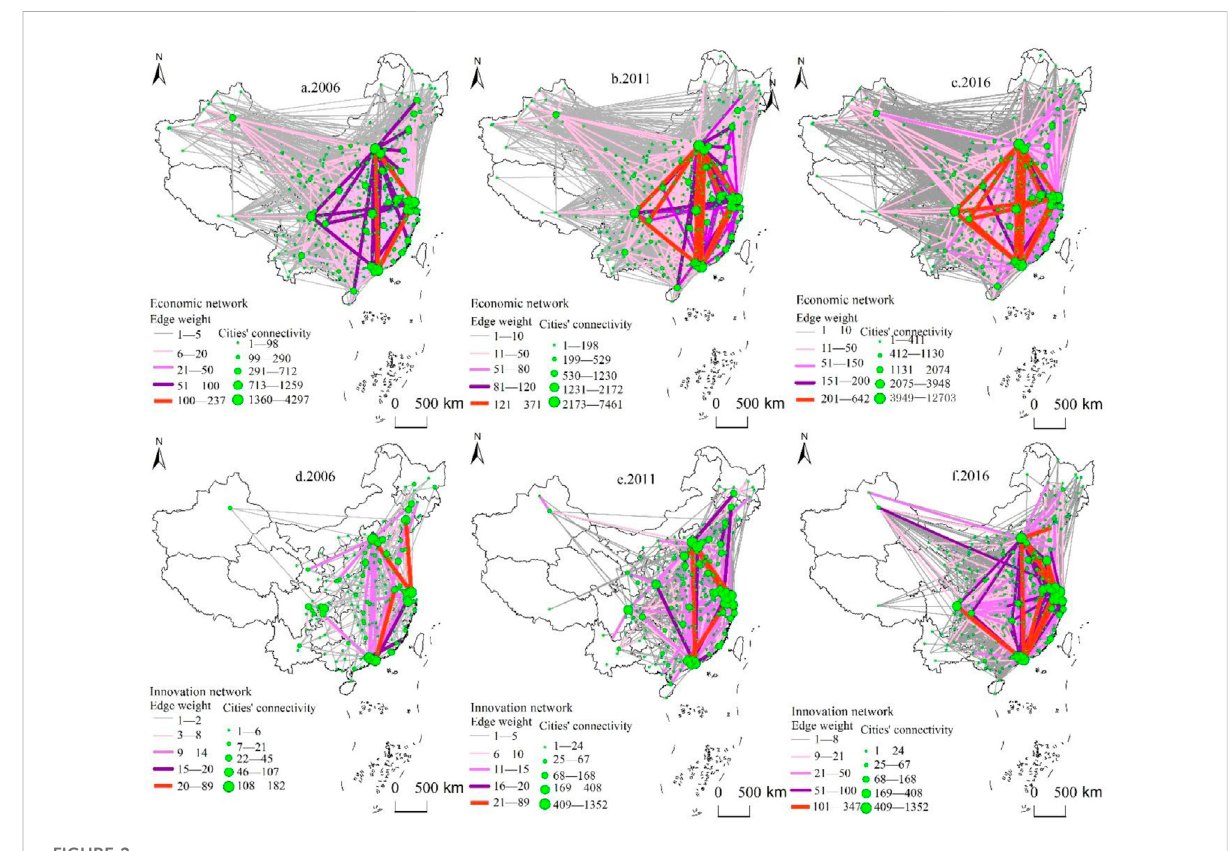
FIGURE 2 Evolution of urban economic network and innovation network in